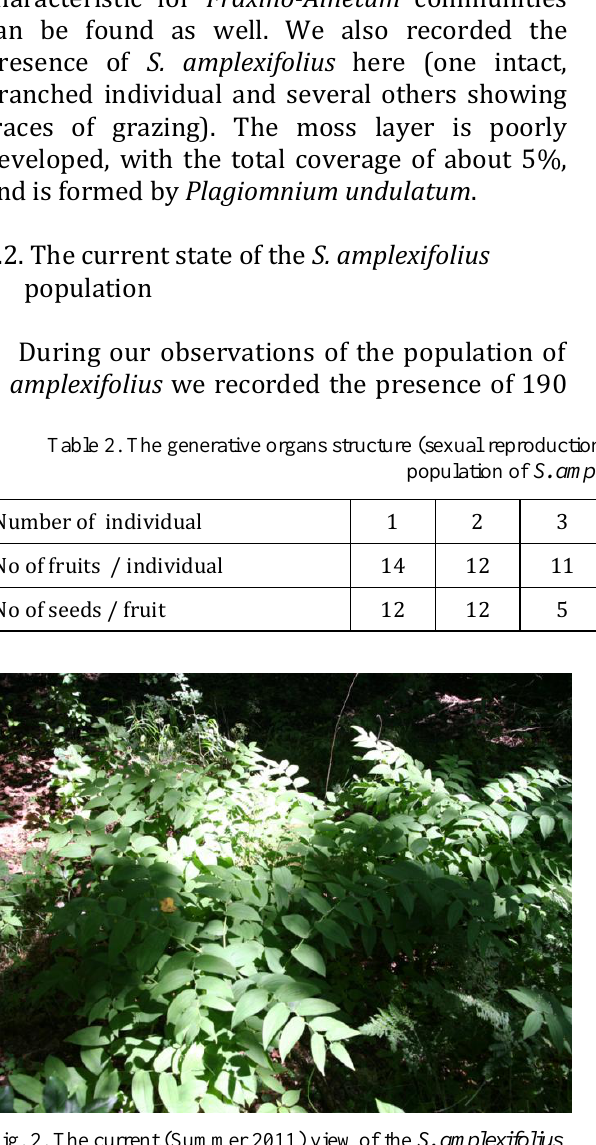
Fig. 2. The current (Summer 2011) view of the S. amplexifolius population near Koszęcin, Silesian voivodeship (authors)